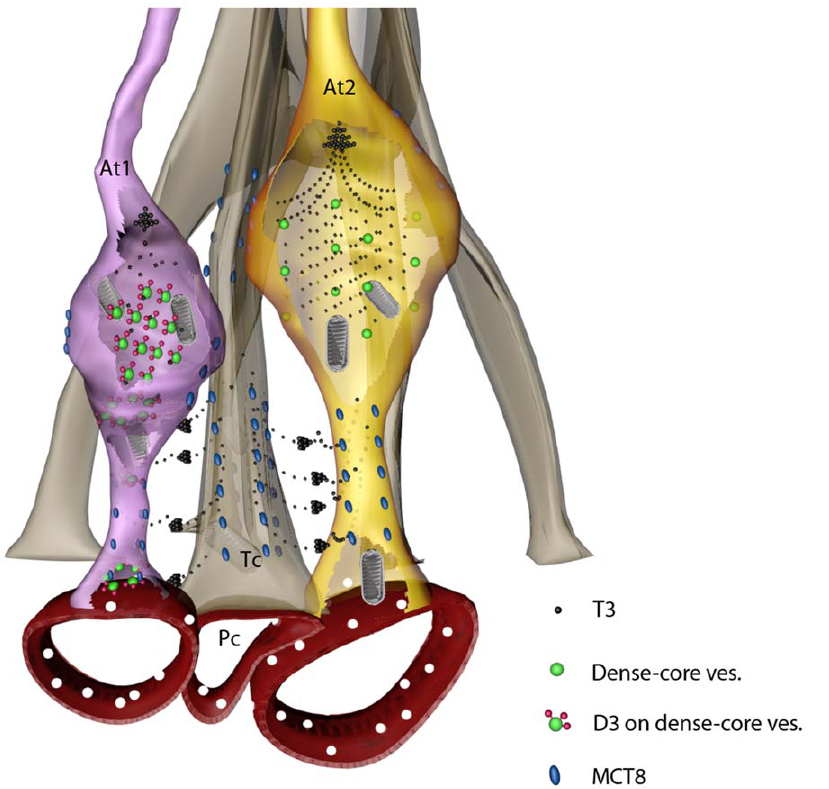
Figure 12. Schematic illustration of axonal uptake and regulation of T3 in the mediobasal hypothalamus. We suggest that T3 generated by D2 is released from tanycyte processes and taken up by MCT8 into axons of hypophysiotropic neurons. T3 concentrations are subjected to local regulation by D3-containing axon varicosities (At1), but absent in D3-negative axons (At2). T3 could be subjected to retrograde transport to reach the soma and nucleus of hypophysiotropic neurons and/or could act locally by affecting mitochondrial function and local thermogenesis. At, axon terminal; Tc, tanycyte; Pc, portal capillary.